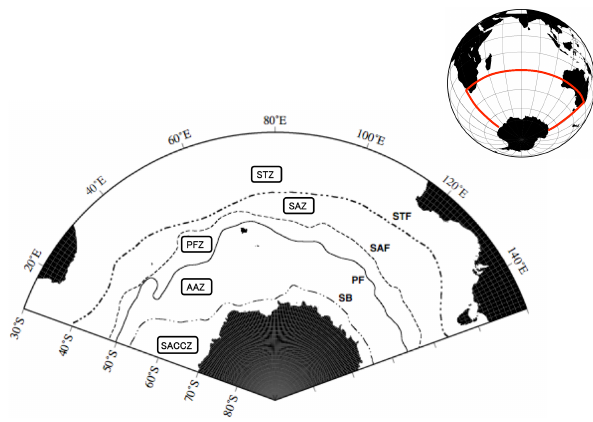
Fig. 1. Climatological locations of the four fronts and five frontal zones. STF, Subtropical Front; SAF, Subantarctic Front; PF, Po- lar Front; SB, Southern Boundary; STZ, Subtropical Frontal Zone; SAZ, Subantarctic Frontal Zone; PFZ, Polar Frontal Zone; AAZ, Antarctic Zone; SACCZ, zone south of the ACC (Antarctic Circum- polar